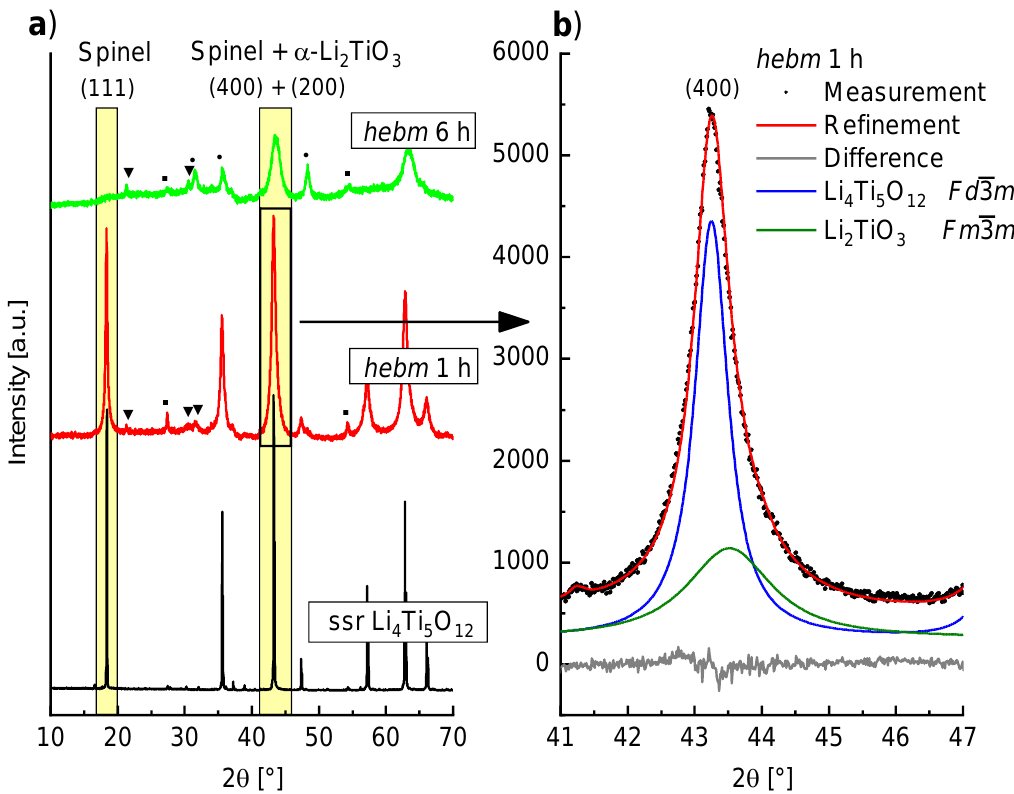
Figure 8. ( a ) PXRD of spinel Li 4 Ti 5 O 12 before and after milling in WC tools at 400 rpm for 1 h and 6 h. Data of Li 4 Ti 5 O 12 were scaled by a factor of 0.5. Triangles indicate Li 2 CO 3 , squares indicate rutile and circles indicate WC reflections; ( b ) Enhanced section of the Rietveld plot after milling for 1 h, with fitted portions of spinel (blue) and NaCl type structure (green).